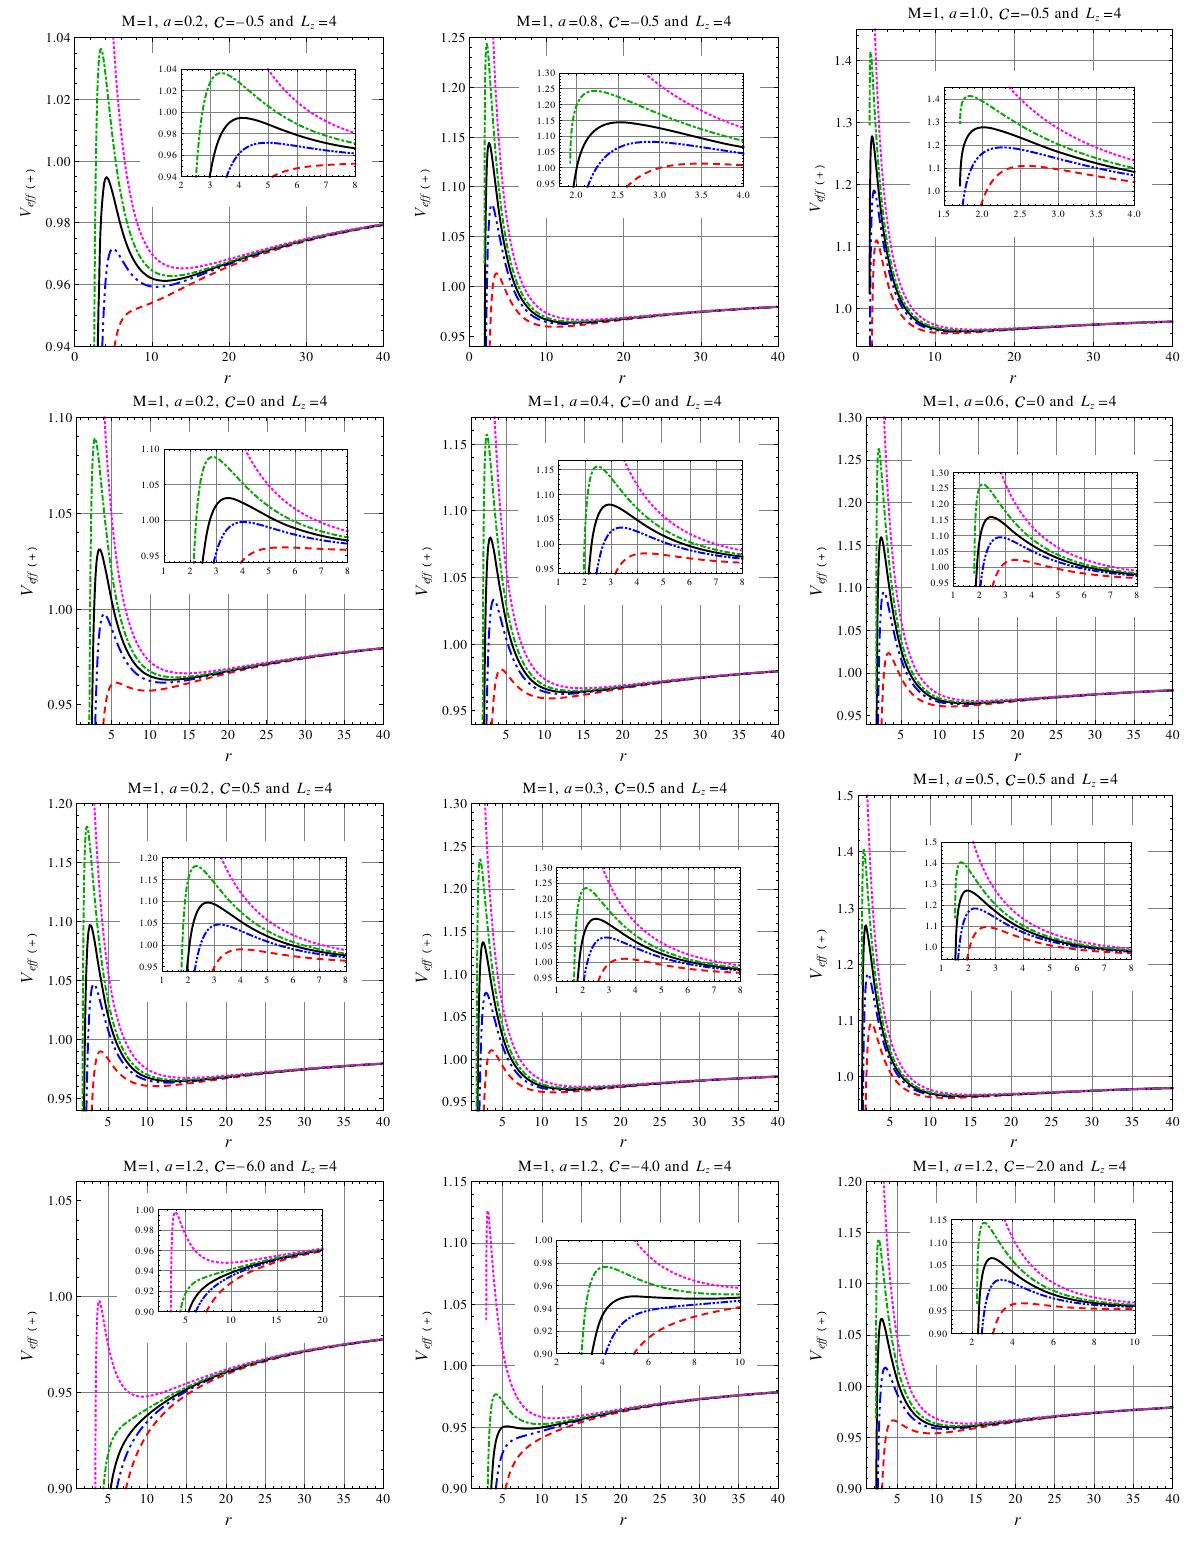
Fig. 3 Plots of the effective potential of a spinning test particle mov- ing in the rotating braneworld BH background for different values of particle spin ( S ). Here, for dashed (Red) curve S = − 1 . 5, for double